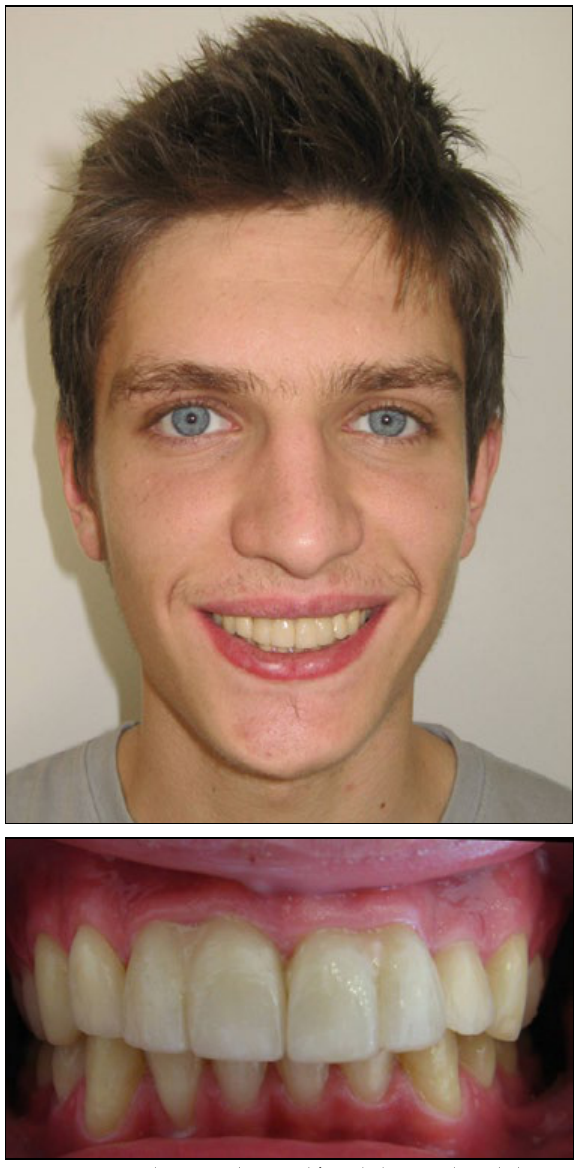
Figure 9, 10. Final extra- and intraoral frontal photographs with the porcelain laminate veneers.